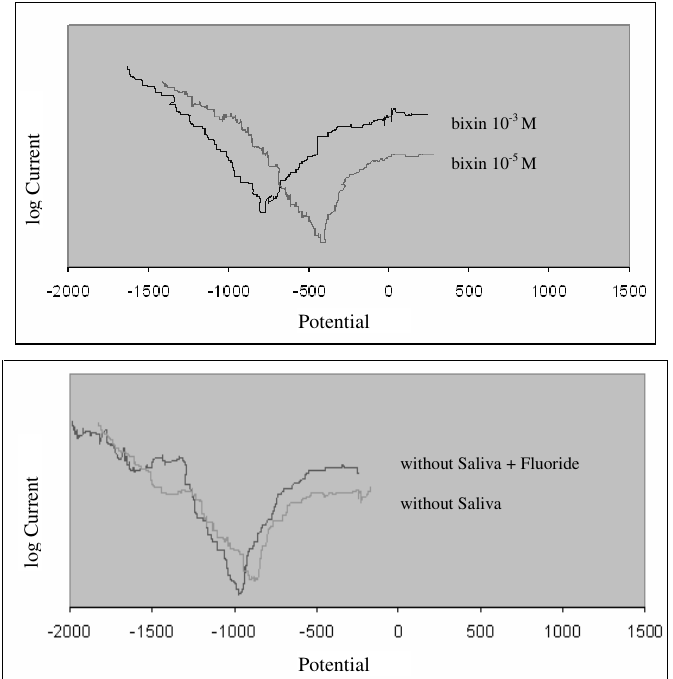
Figure 2 . Polarization curves after 1 h of immersion in fluoride medium saliva pH 2 with fluoride for Ti. Table 2 . Summary of electrochemical parameters for grade-2 in fluoridemedia at different concentration of